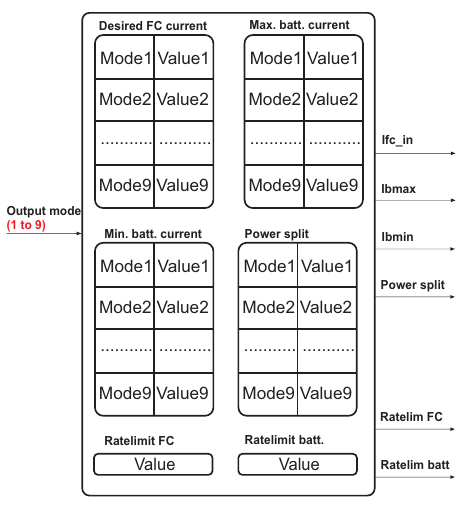
Figure 17. Details of the look-up table